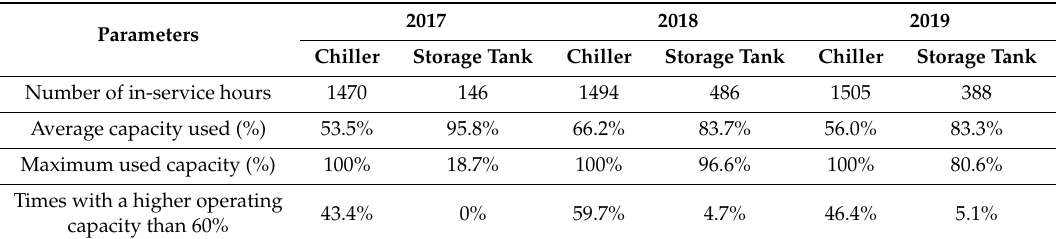
Table 3. The cooling system operating statistics when sized based on the new sizing strategy and adding a cold storage